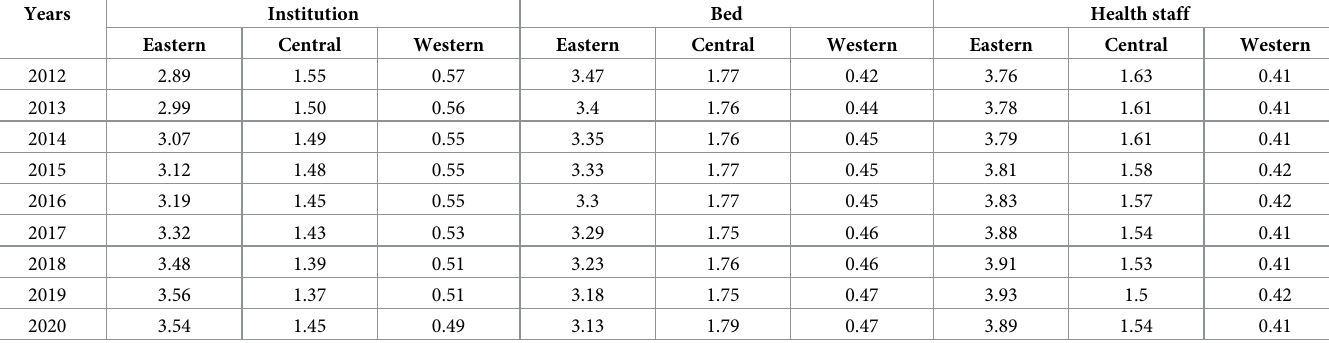
Table 3. The geographic area-based agglomeration degree of TCM health resource from 2012–2020. Years